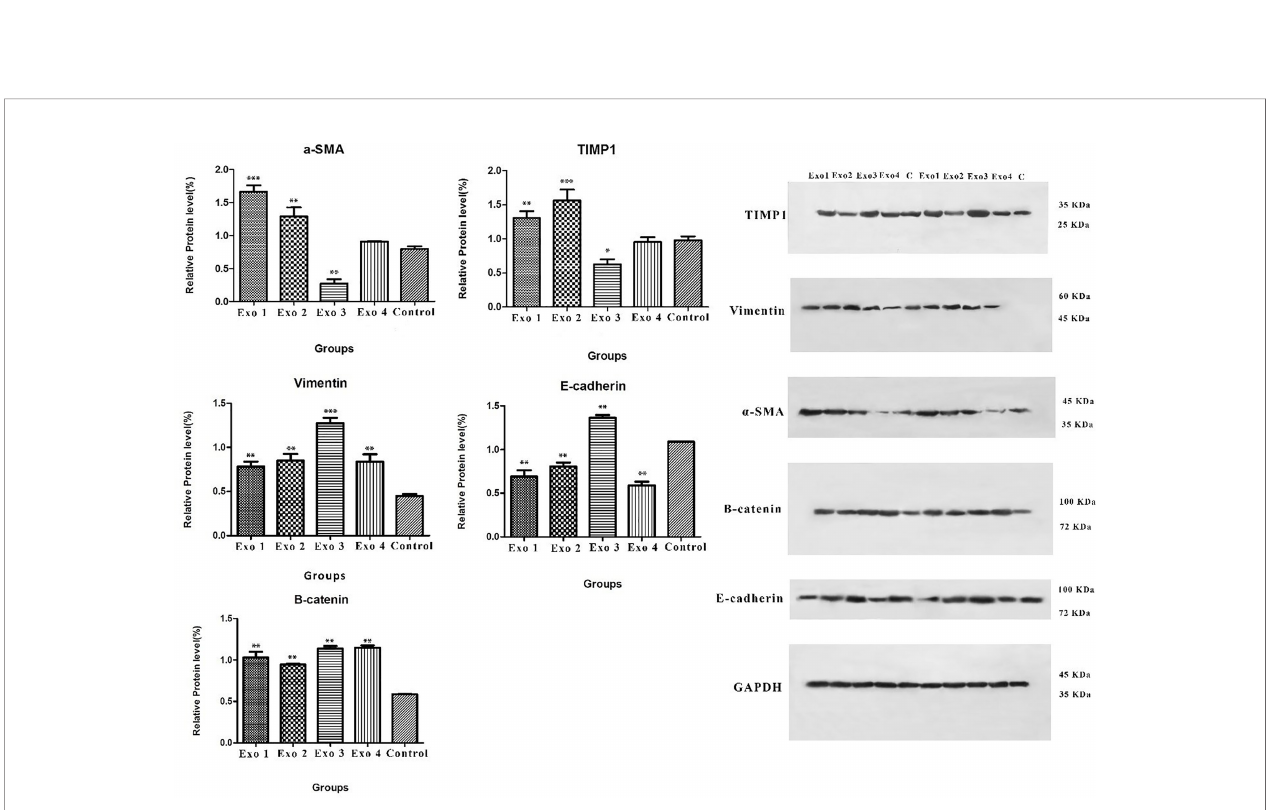
FIGURE 4 | Immunoblotting result of vimentin, b -catenin, TIMP1, a -SMA and E-cadherin protein expressions. As it shown vimentin, b -catenin, TIMP1, a -SMA protein expression of HSCs increased after treatment with infected hepatocytes-derived exosomes. Data presented as means ± standard error (SEM) for three independent experiments. Data are shown as the mean ± SEM. * P < 0.05, ** P < 0.01, and *** P < 0.001 by post hoc one-way ANOVA statistical analysis. Scale bar: 20 µm, magni fi cation